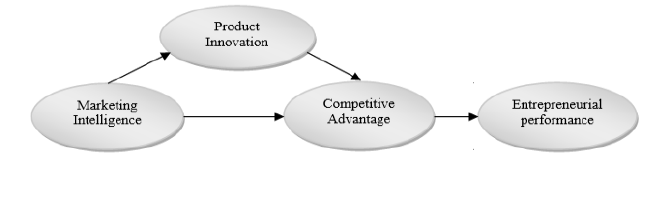
Figure 1: Conceptual